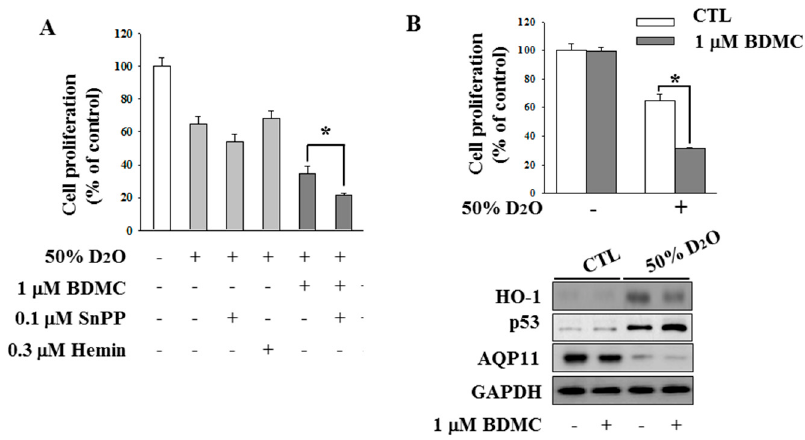
Figure 3. Cotreatment of HSC-T6 cells with deuterium oxide (D 2 O) and bisdemethoxycurcumin (BDMC) decreased the expression of heme oxygenase (HO)-1. HSC-T6 cells were incubated with or without 50% D 2 O for 24 h. In addition, the D 2 O-treated cells were exposed to 1 µM BDMC, 0.1 µM SnPP (tin protoporphyrin), or 0.3 µM hemin ( A ). The effects of cotreatment of HSC-T6 cells with D 2 O and BDMC on their proliferation and expression of HO-1, p53, and AQP11 ( B ). The expression of HO-1, p53, and aquaporin (AQP) 11 was assessed by western blotting. GAPDH served as the loading control. Data are representative of three independent experiments and are expressed as mean ± SD, * p < 0.05.